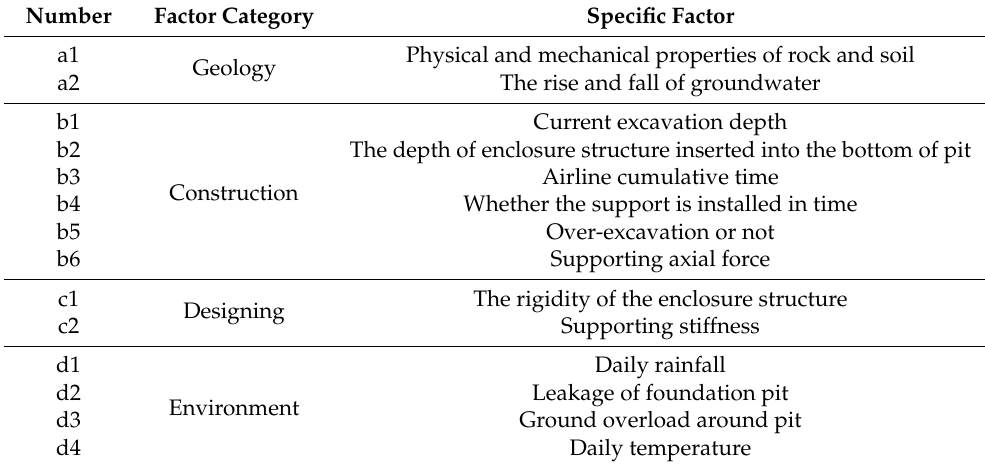
Table 1. Factors of the foundation pit